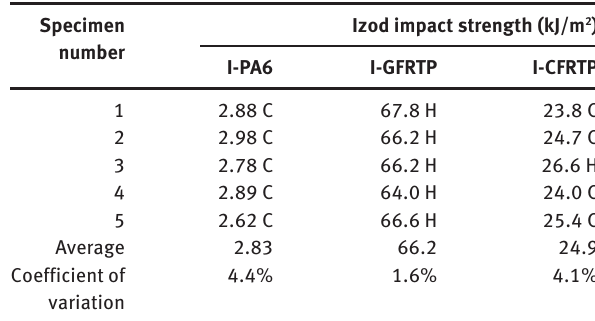
Table 1 Impact strength of various kinds of